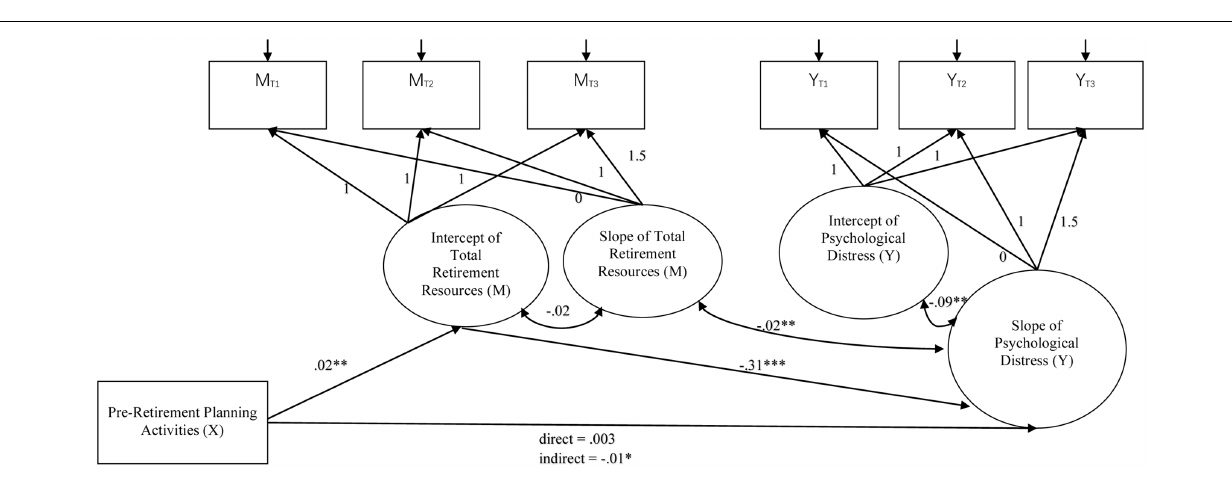
FIGURE 5 | The latent growth mediation model on psychological distress. X denotes the independent variable; M denotes the mediator; and Y denotes the dependent variable. The model fit indices are: CFI = 0.909; RMSEA = 0.154; AIC = 389.006; BIC = 460.823. Age and gender were controlled in the model as covariates. ∗ p < 0.05; ∗∗ p < 0.01; ∗∗∗ p <